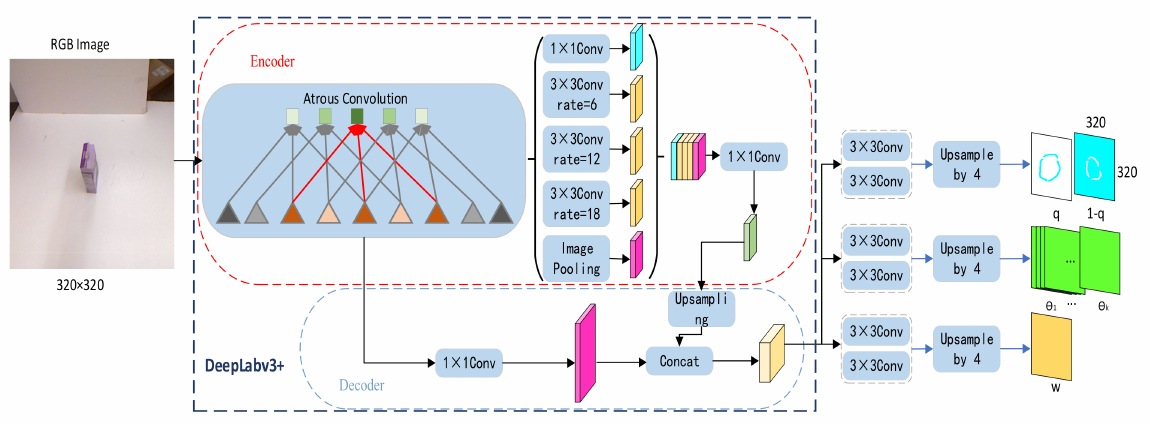
Figure 3. The construction of